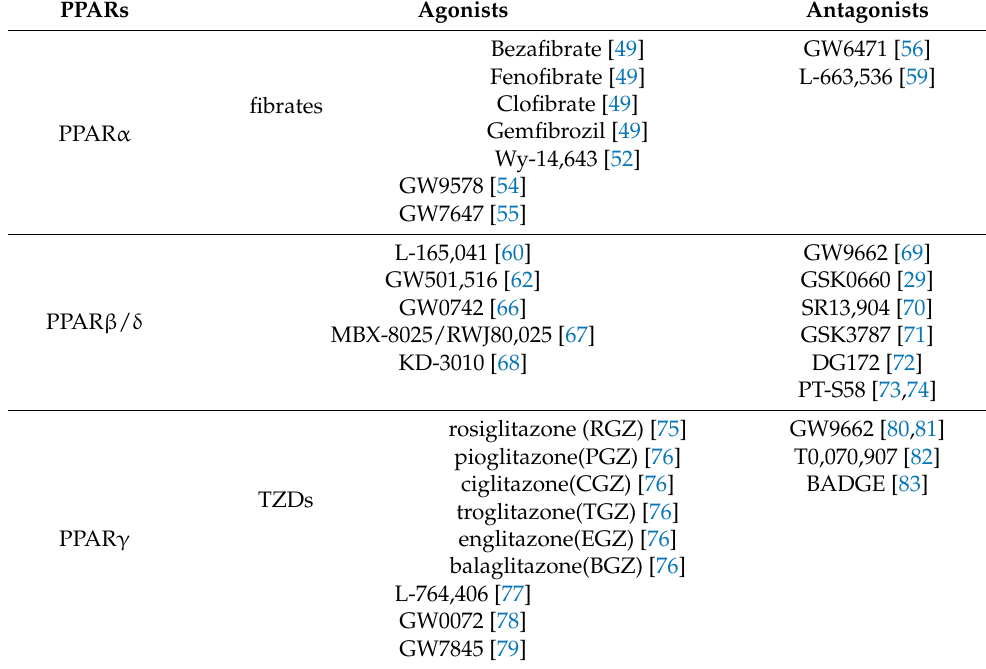
Table 1. Agonists and antagonists of